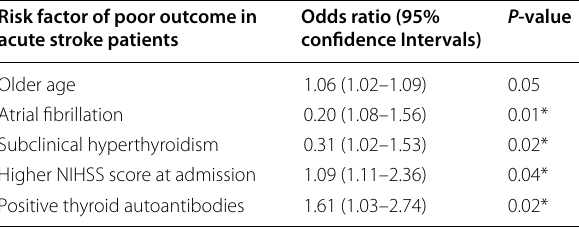
Table 4 Logistic regression analysis of factors predicting poor outcome at 1 year in acute stroke